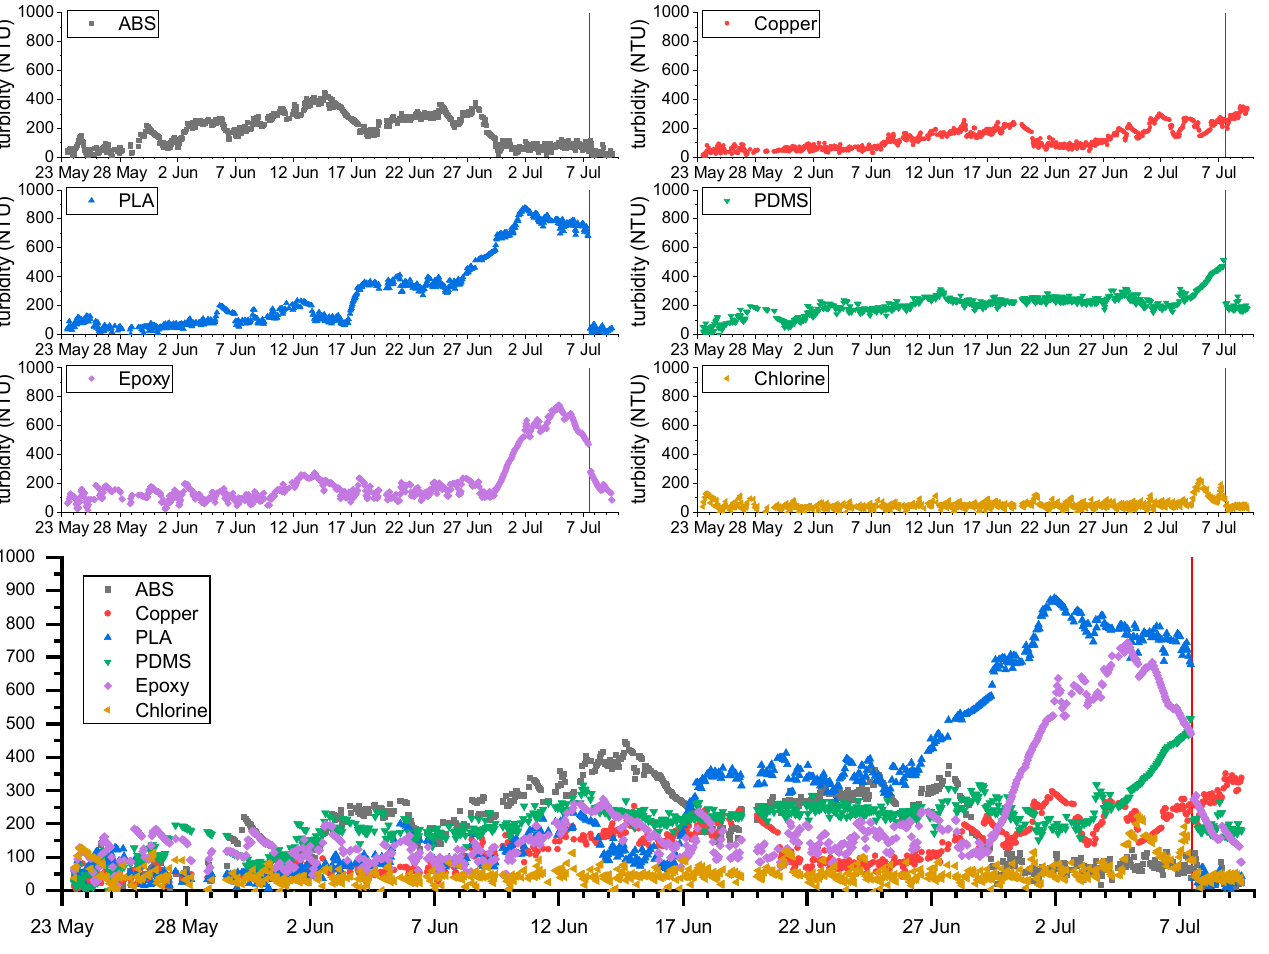
Figure 4. Turbidity measurements of the six anti-biofouling techniques during the in situ experi- ment. The vertical red line marks the date when the probes were taken out of the water for the in situ cleaning.